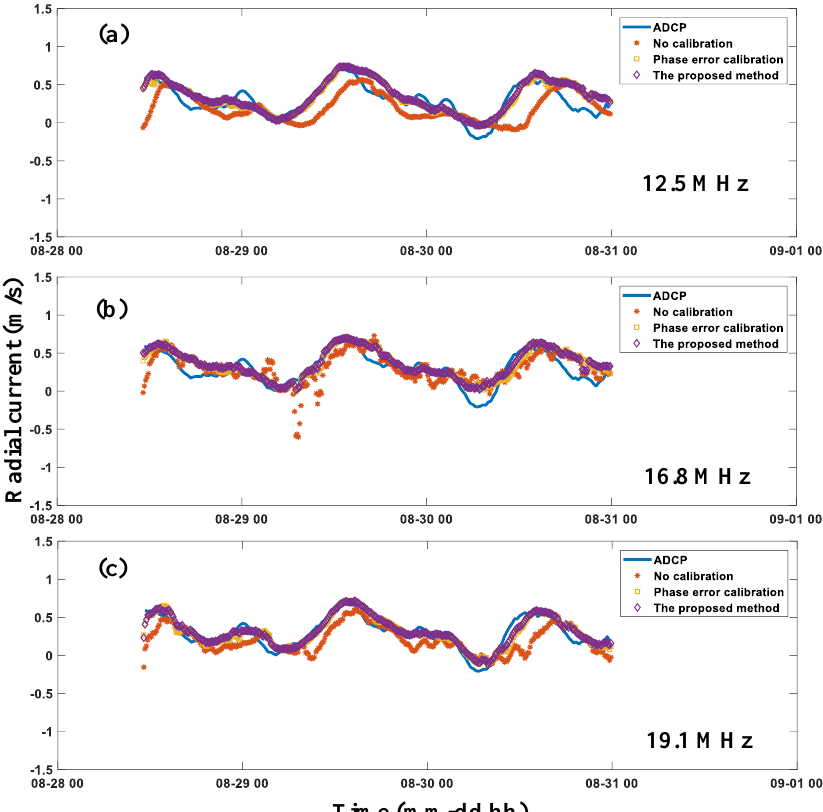
Figure 12. Comparisons between the MHF radar-derived radial currents and ADCP data. Only four-element datasets are involved in the MHF radar radial current measurements. ( a ) 12.5 MHz; ( b ) 16.8 MHz; and, ( c ) 19.1